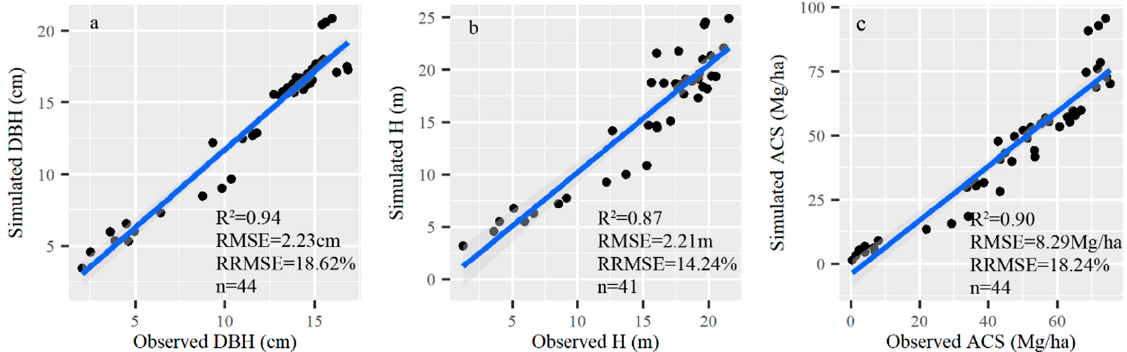
Figure 6. Validation of simulated diameter at breast height ( a ), height ( b ), and aboveground carbon stock ( c ) based on remote sensing stand age data at SP scale.